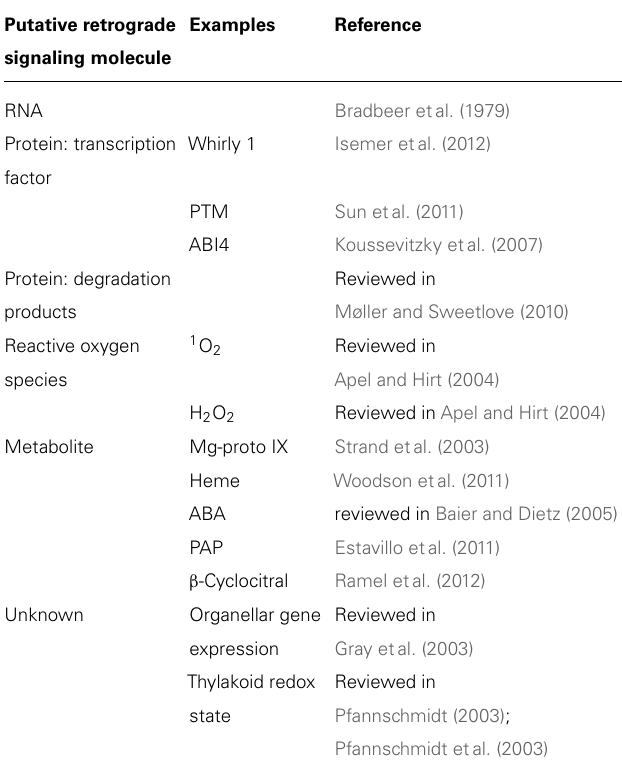
Table 1 | Overview of different classes of putative retrograde signaling